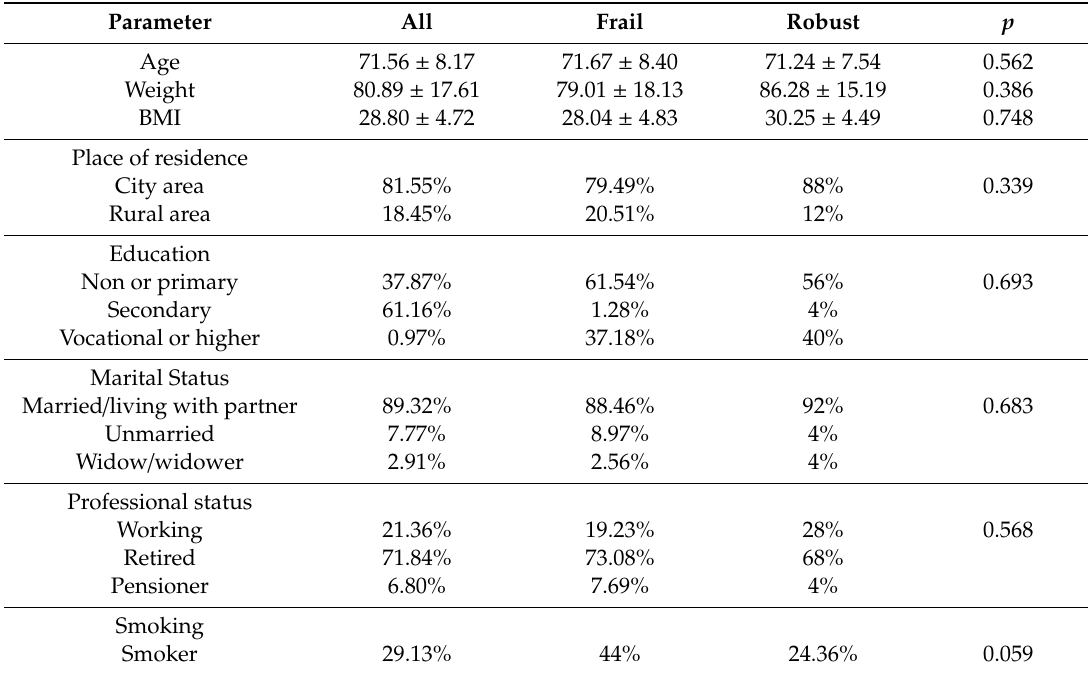
Table 1. Characteristics of the patients that were included in the study.